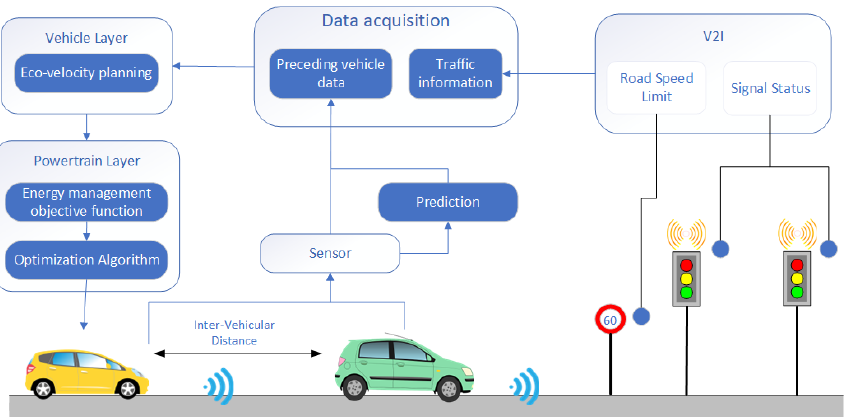
Figure 9. The scenario of double-vehicle considering the safety constraints with preceding